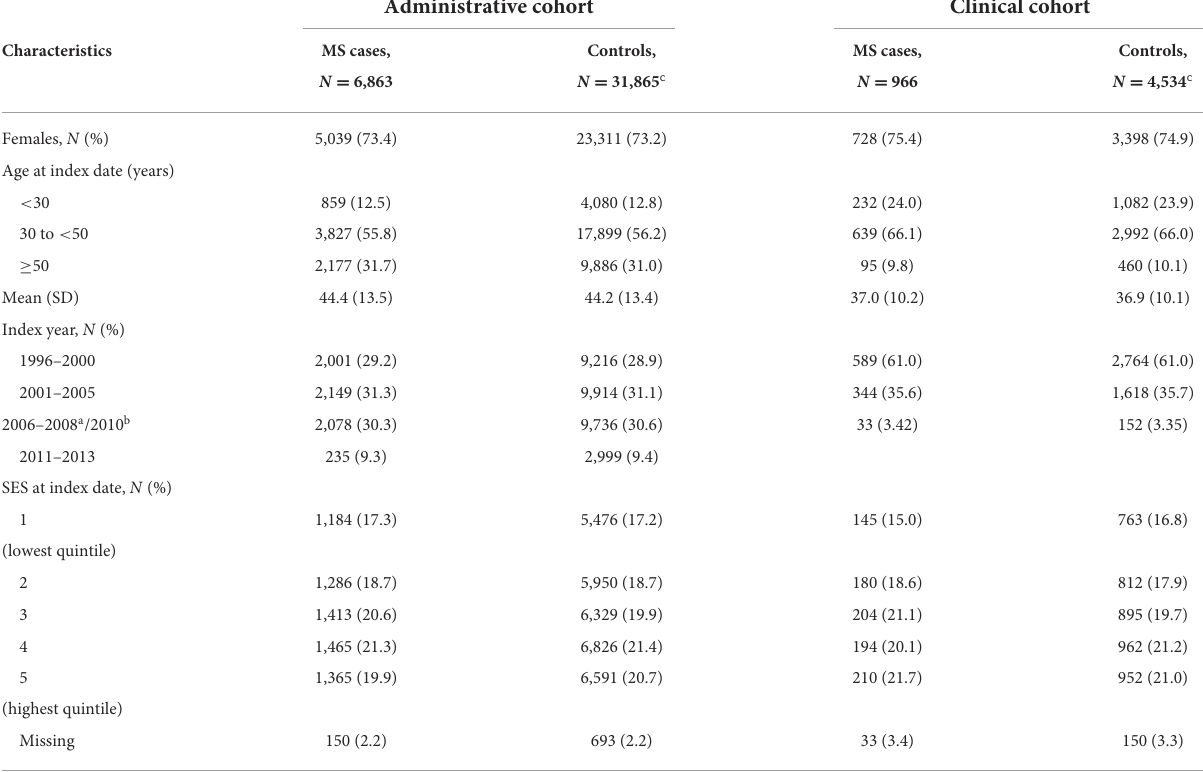
TABLE 1 Characteristics of the multiple sclerosis (MS) cases and controls in the administrative and clinical cohorts at the index date in British Columbia, Canada. Administrative